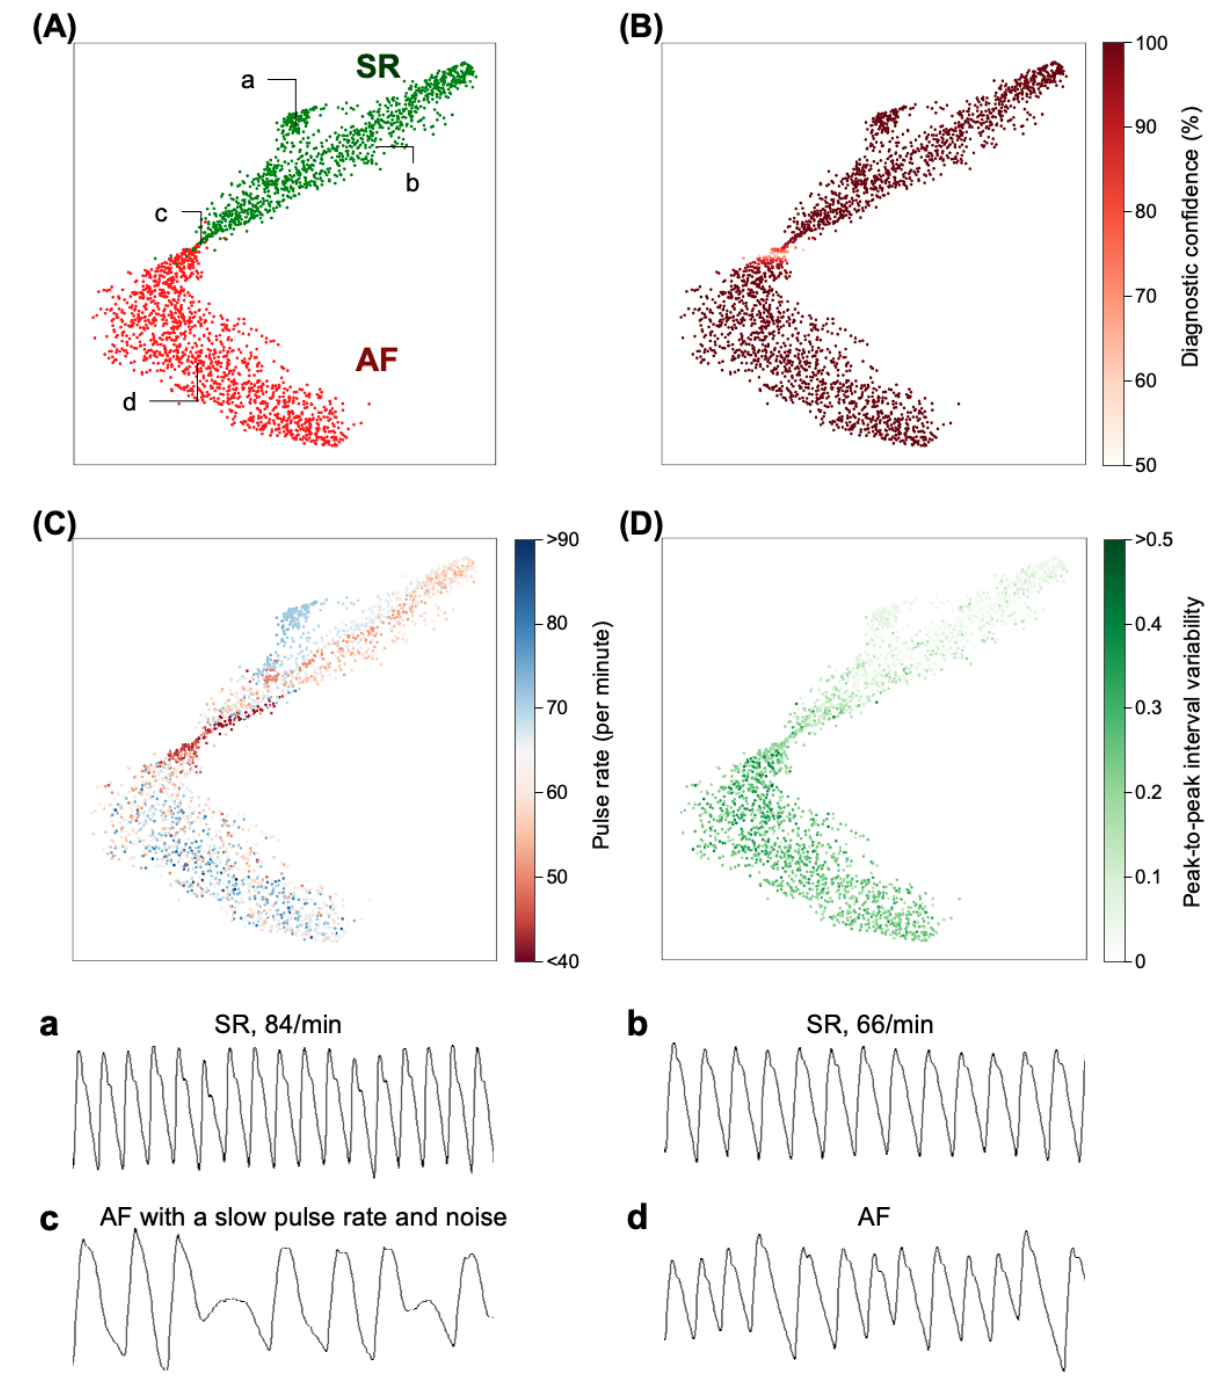
Figure 6. Visualization of deep learning analyses. The deep learning analyses of CardioTracker are plotted with the t-SNE method. The upper panel: (A) The two clusters of AF and SR were well differentiated from each other, leaving a small overlapped potion. (B), (C), and (D) The overlapped region showed low diagnostic confidence, low pulse rates, and modest peak-to-peak interval variability. The lower panel: typical examples of photoplethysmography samples. AF: atrial fibrillation, SR: sinus rhythm, t-SNE: t-distributed stochastic neighbor